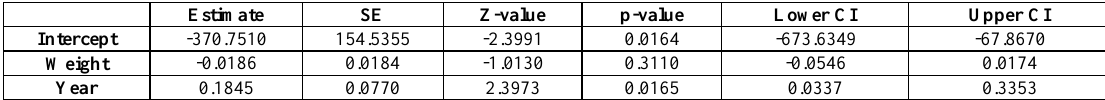
Table 5. Estimates for mixed effects model